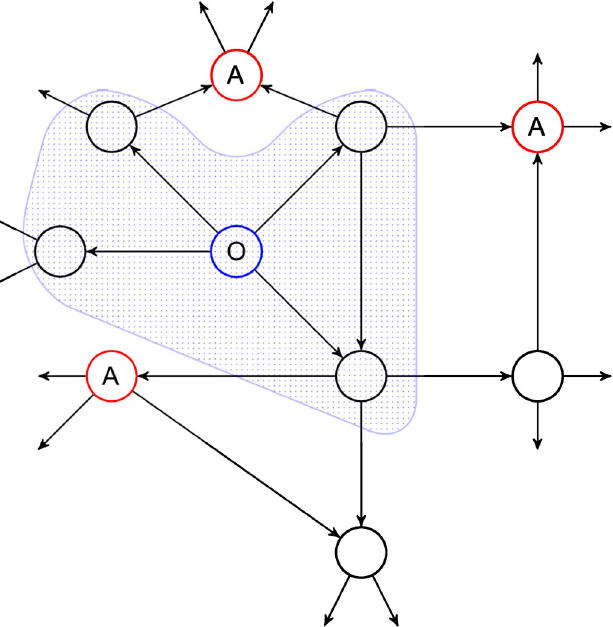
Fig 1. Motivating example: The originator of a message (O, blue) disseminates a message along the connections (arrows). The area highlights all nodes that received the message so far. Attackers (A, red) distributed throughout the network will receive the message in the next step and can reconstruct the originating node.